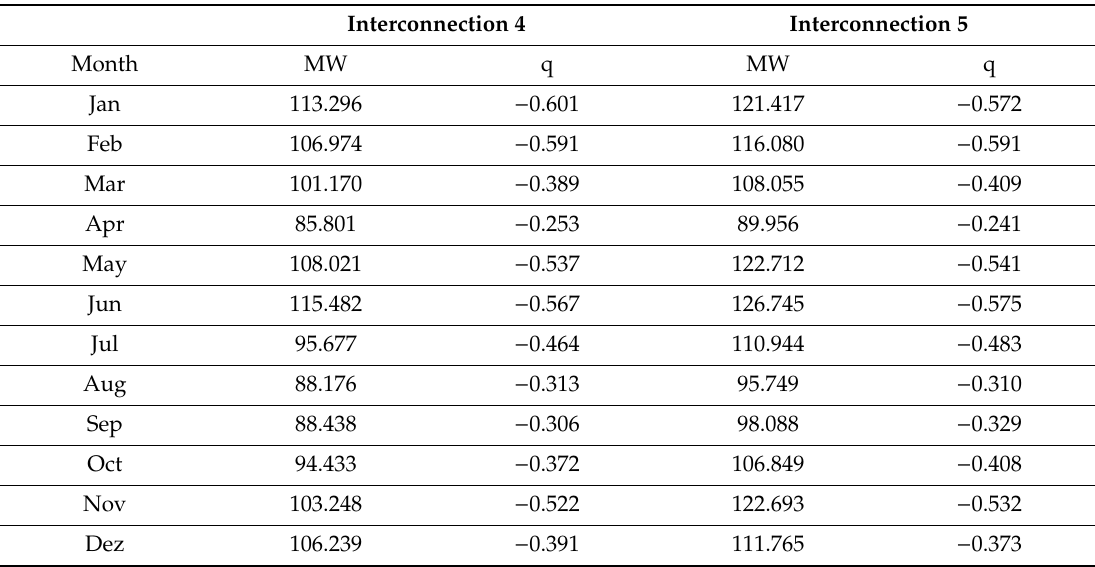
Table 2. Interconnection Capacities.